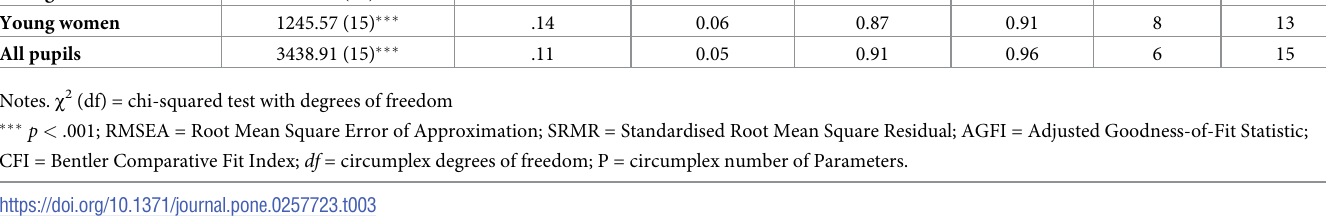
minor deviations regarding circular fit can be expected.